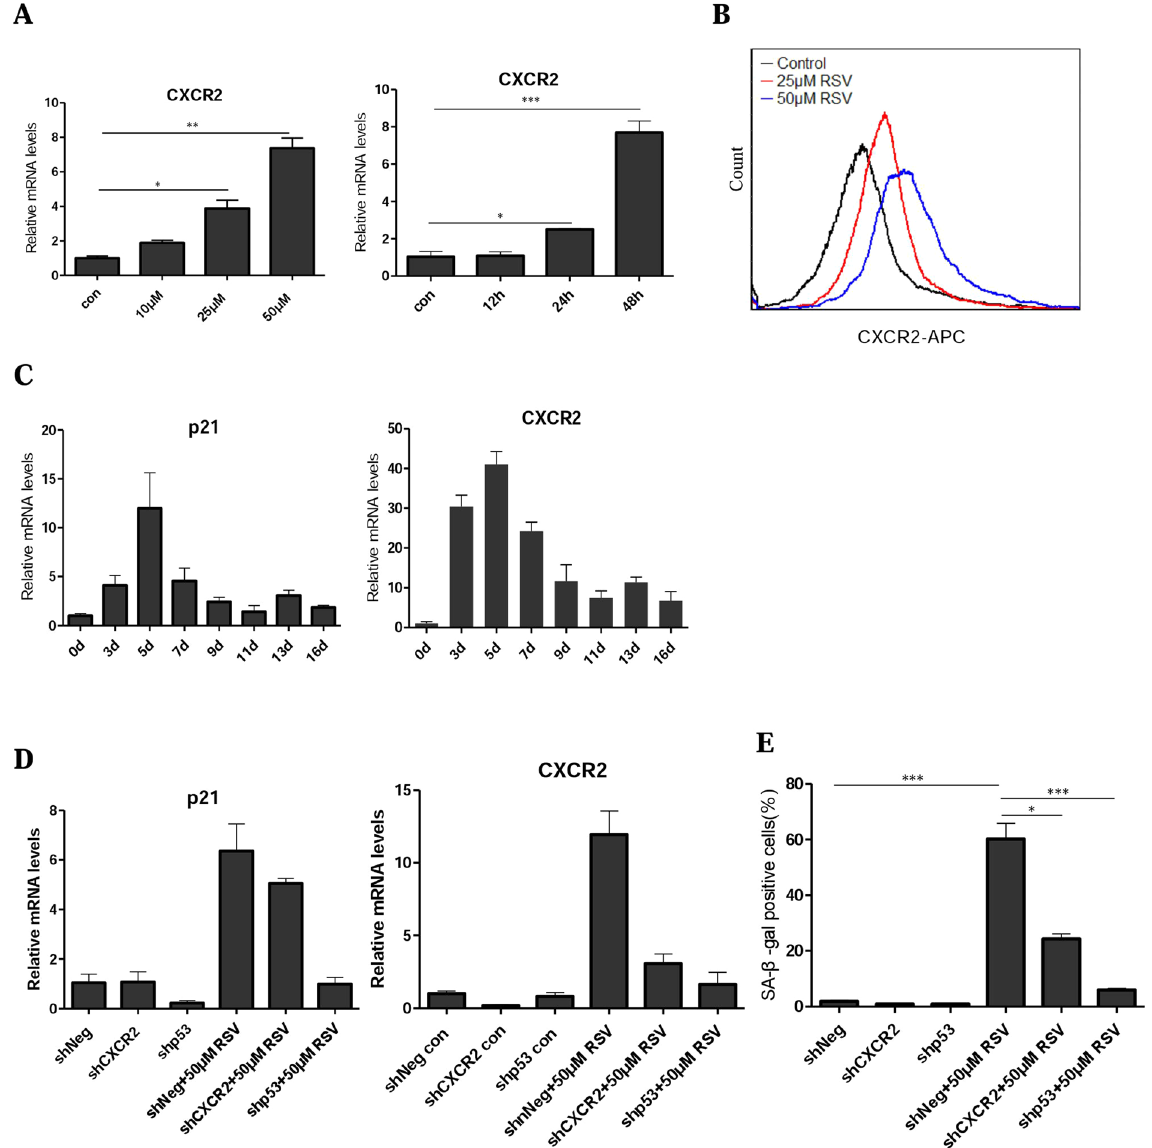
Figure 5. Upregulation of p53-CXCR2 axis mediates cellular senescence. ( A ) CXCR2 mRNA was determined using RT-PCR. U2OS cells were treated with different concentration of RSV for 48 h (left) and 25 μ M RSV for 12, 24 and 48 h (right). ( B ) Detection of CXCR2 by flow cytometry using mouse anti-human CD182 antibody. Cells were treated with RSV (25 and 50 μ M) for 48 h. ( C ) p21 and CXCR2 mRNAs were determined using RT- PCR. U2OS cells were treated with 25 μ M RSV for the indicated days. ( D ) The mRNA levels of CXCR2, p21 in shNeg, shp53 and shCXCR2 U2OS cells were measured 48 h after treatment with RSV (50 μ M). ( E ) The cells were treated the same as ( D ), on day 7, cellular senescence was examined by SA- β -gal